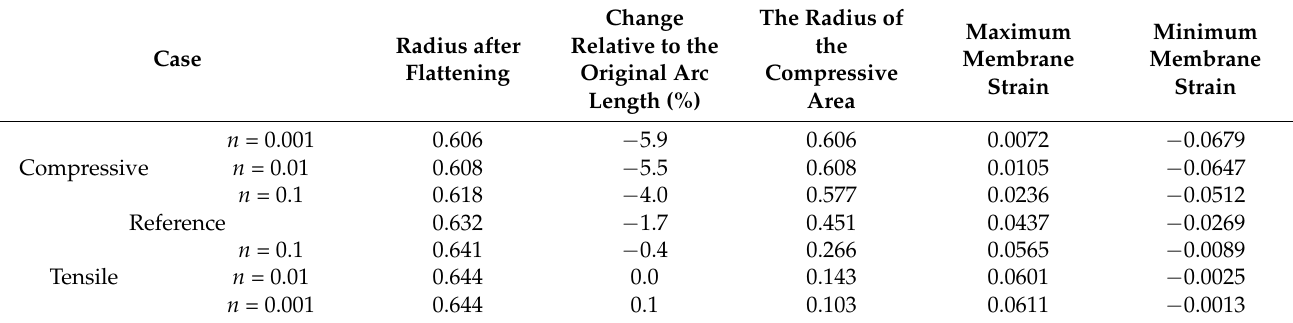
Figure 5. The dimension of the spherical cap. Table 1. Comparison of spherical cap shape-flattening